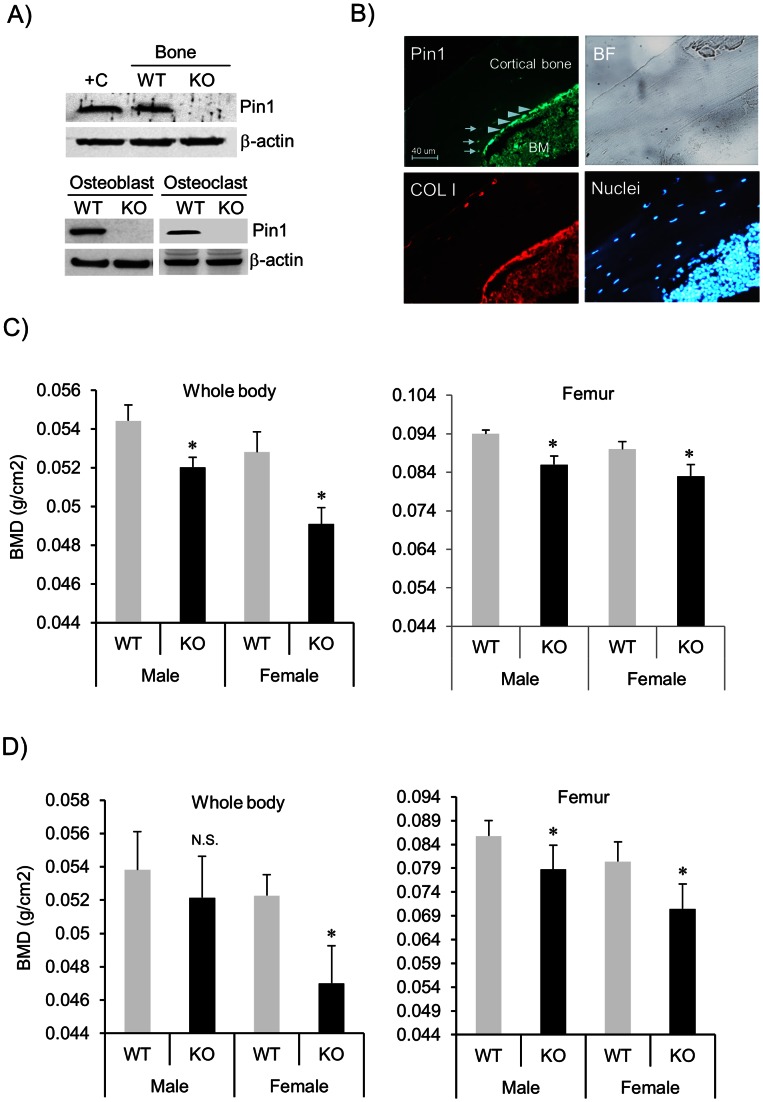
Bone mineral density (BMD) is decreased in Pin1 KO mice.(A) PIN1 is expressed in mouse bone, osteoclasts and osteoblasts. Top: Immunoblot of total cell lysates from human eosinophils (+C) and humerus bone of PIN1 WT and KO mice. Bottom: Immunoblot of bone marrow derived osteoblasts and osteoclasts. (B) Femoral bone was triple-stained with anti-PIN1 (green), anti-COL-I (red) and Hoechst dye (blue) for visualization of nuclei. Bone from KO mice was stained negative for green (data not included). BM: bone marrow. Arrow head: Osteoblasts. Arrow: Osteocytes. BF: bright field. (C) Whole body (left) and femoral (right) bone mineral density (BMD) of 4 month-old wild-type and Pin1 KO mice (littermate) were measured non-destructively by DXA system. For whole body BMD, we excluded skull and tail for each animal based on skeletal landmarks from the grey-scale images. Femoral BMD was measured ex vivo after isolating femurs from same mice. (D) BMD of 18 month-old mice was measured as in (C). *denotes p<0.05 by paired student t-test with 8 mice per group.